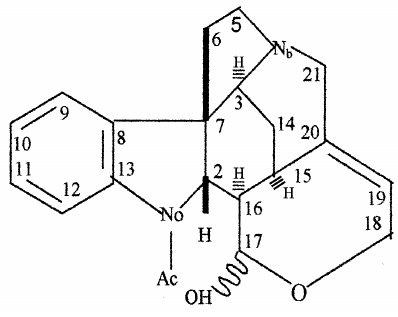
Figure 1 . The structure of Diaboline.